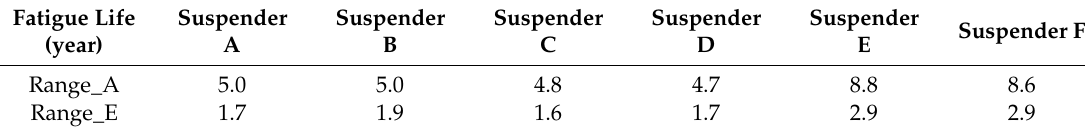
Table 8. Fatigue life estimation under di ff erent road roughness considering corrosion e ff ects. Fatigue